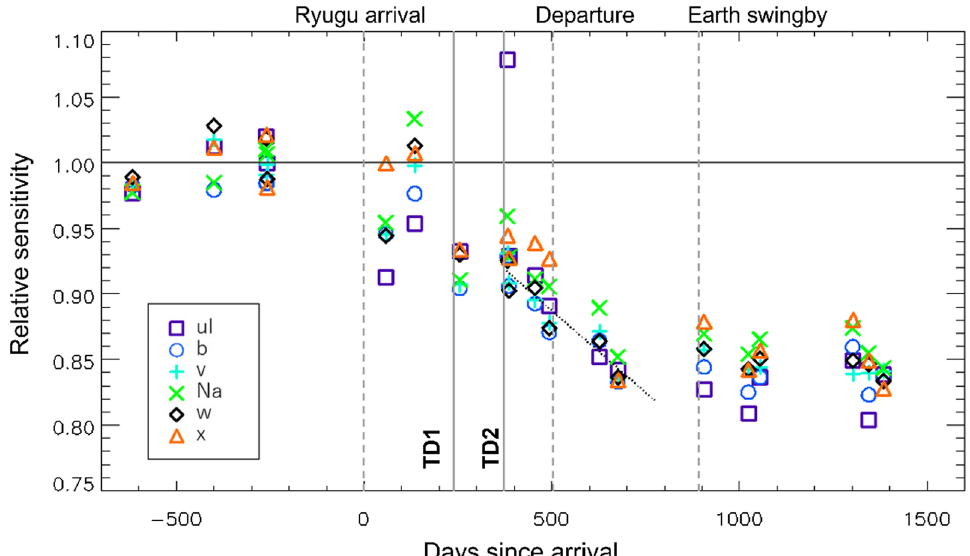
Fig. 7 Sensitivity variations of the ul–x bands measured from stellar observations since Hayabusa2’s launch. The measured sensitivity for each band was normalized by the value in Tatsumi et al. (2019), which was measured in space before arrival. A fitted trend for the sensitivity degradation of the v band after TD2 is also plotted (dotted line)